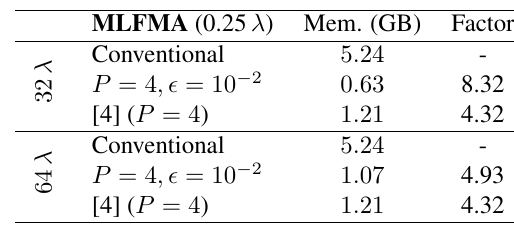
Table 4: Memory for the aggregation matrices with dif- ferent compression techniques using MLFMA (box size: 0.25 λ ). Example: square plate with 1 085 544 unknowns for the edge lengths a = 32 λ and a = 64 λ .